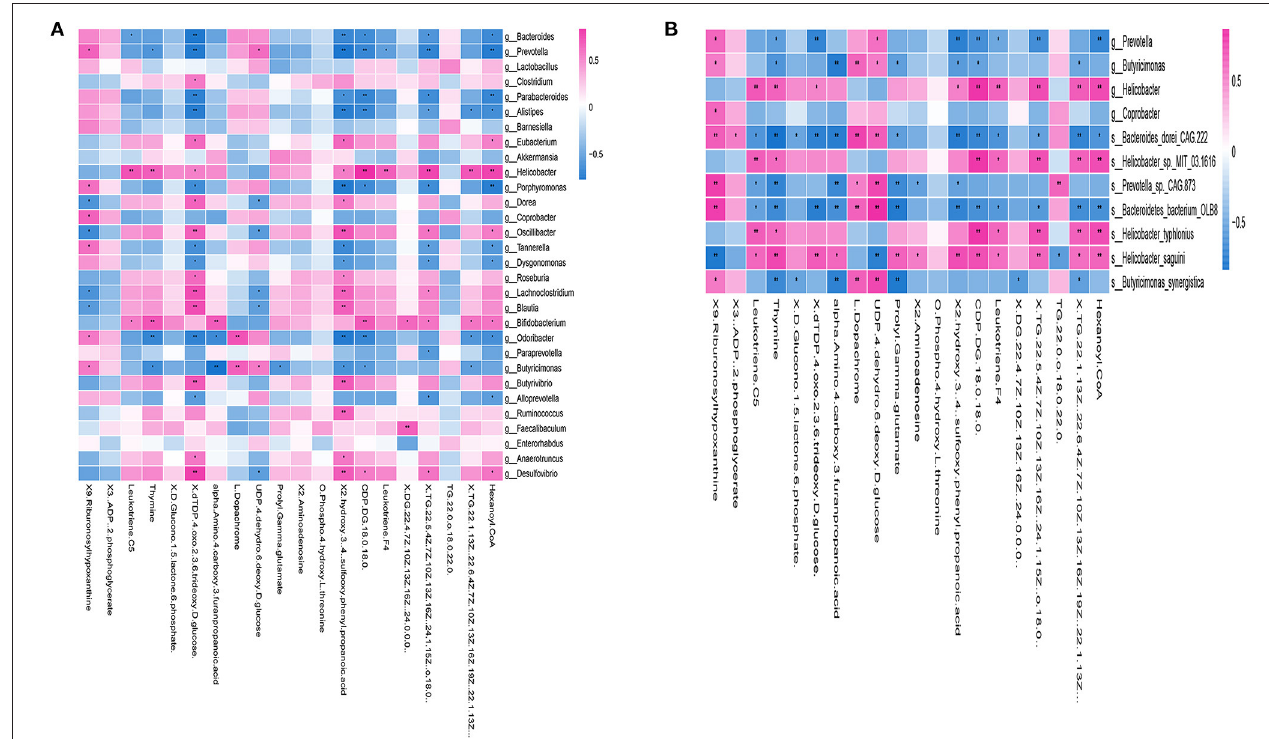
FIGURE 7 | Correlation between gut microbiotas and metabolites. (A) Correlation analysis at the genus level of the 30 most abundant gut microbiotas and 20 different metabolites. Some microbiotas were correlated with specific metabolites, including g_Clostridium , which showed a positive correlation with dTDP-4-oxo-2,3,6-trideoxy-d-glucose ( p < 0.05), and g_Faecalibaculum , which had a positive correlation with DG (22:4(7Z,10Z,13Z,16Z) ( p < 0.01). (B) The heat map of the most abundant species and 20 different metabolites. The correlation analysis revealed that both of s_Bacteroides_dorei_CAG222 and s_Bacteroidetes_bacterium_OLB8 were correlated with 14 different metabolites, including 9-ribofuranosyl hypoxanthine, leukotriene C5, thymine, dTDP-4-oxo-2,3,6-trideoxy-D-glucose, alpha-amino-4-carboxy-3-furanpropanoic acid, L-dopachrome, UDP-4-dehydro-6-deoxy-D-glucose, prolyl-gamma-glutamate, 2-hydroxy-3-[4-(sulfooxy)phenyl]propanoic acid, CDP-DG(18:0/18:0), leukotriene F4, TG(22:5(4Z,7Z,10Z,13Z,16Z), TG(22:1(13Z)/22:6(4Z,7Z,10Z,13Z,16Z,19Z), and hexanoyl-CoA, all of which were widely related to a variety of metabolisms, such as carbohydrate metabolism and fatty acid metabolism. * p < 0.05, ** p < 0.01; positive correlation is indicated in red and negative correlation is in blue; n =